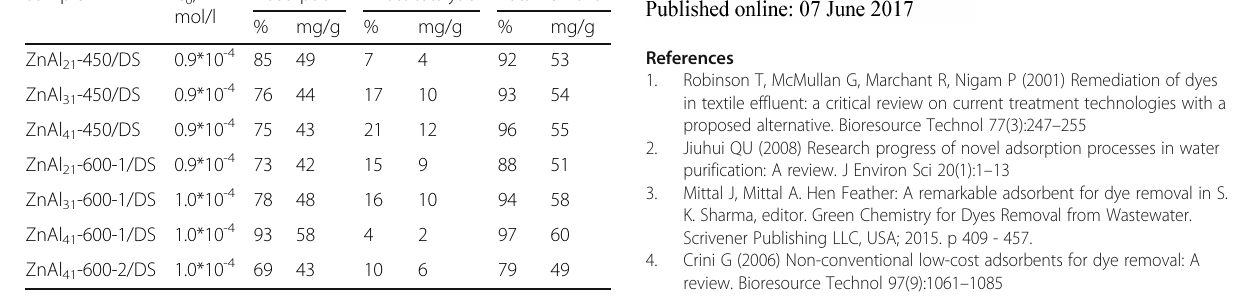
Table 3 The adsorption and photocatalytic removal of MB with DS modified Zn-Al LDHs Sample C 0 , Adsorption Photocatalysis Total mol/l